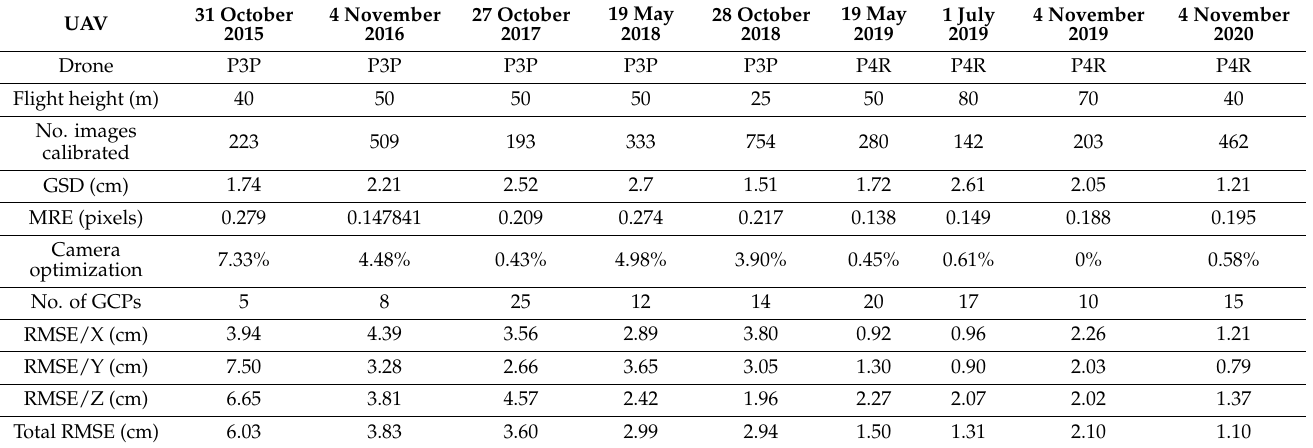
Figure 3. Timing of the UAV surveys for monitoring gully erosion. Table 2. Accuracy parameters of the photogrammetric processing (GSD, ground sample dis- tance; MRE, mean reprojection error; camera optimization, relative difference between the initial and optimized internal camera parameters; GCP, ground control point; and RMSE, root mean square